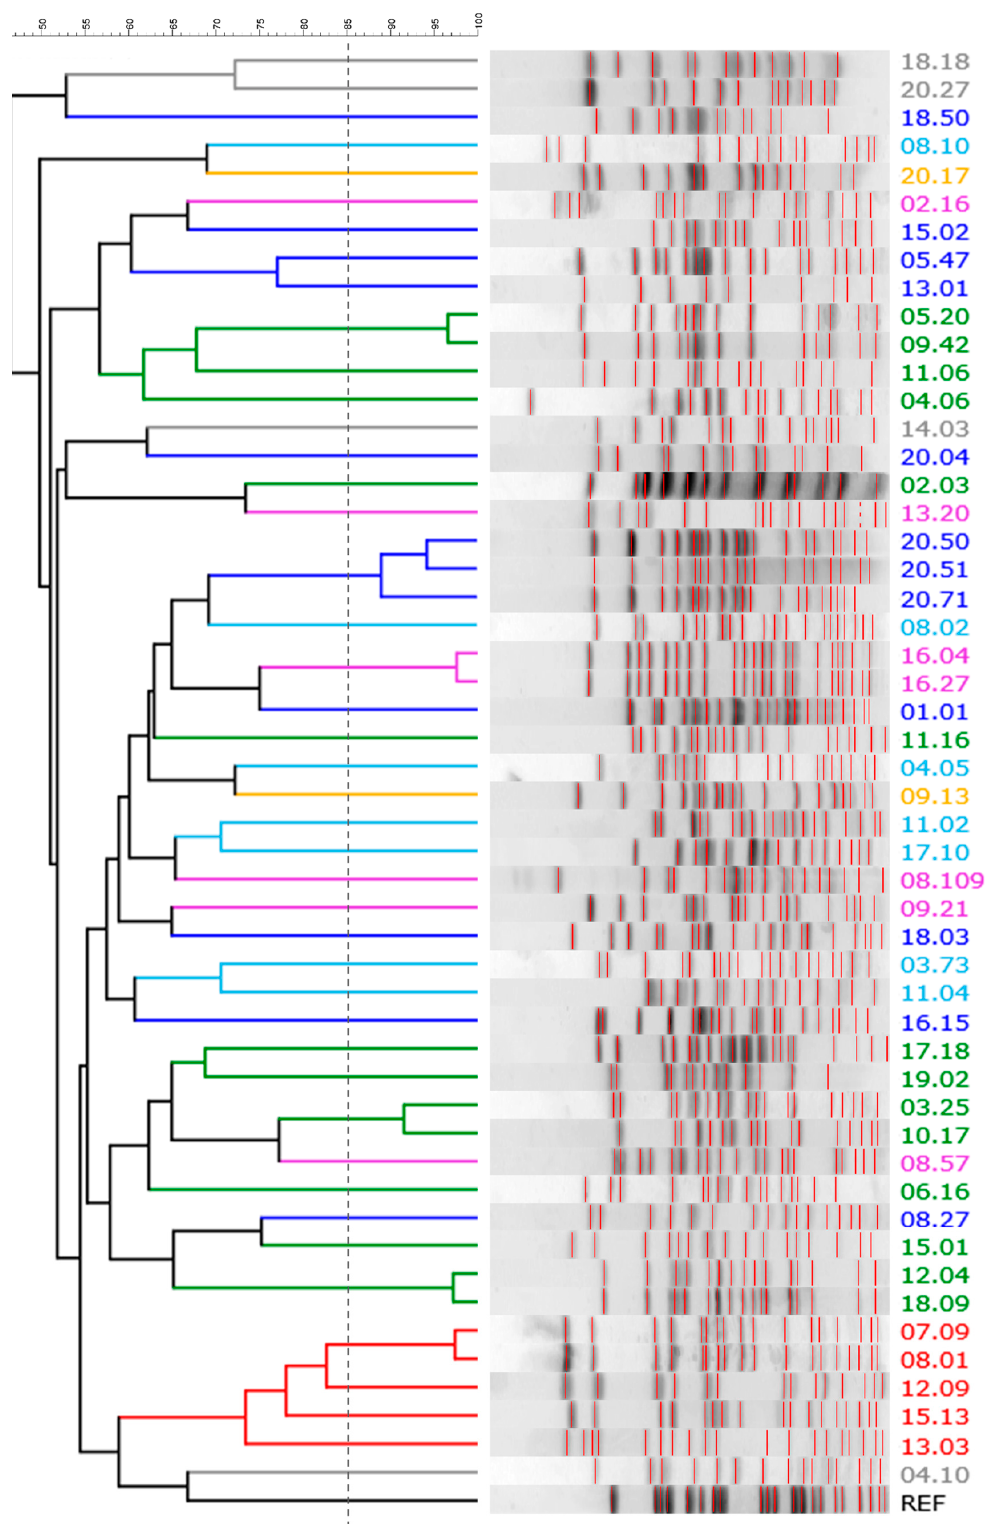
Figure 2. The Xba I-PFGE pattern of E. coli strains: a UPGMA dendrogram derived from Dice’s coefficients, calculated based on their band profiles. Patterns with similarities >85% (dashed line) were ascribed to the same pulsotype. Strains are colored based on their phylogroup: A, cyan; B1, blue; B2, green; C, yellow; D, red; E, grey; F, pink.